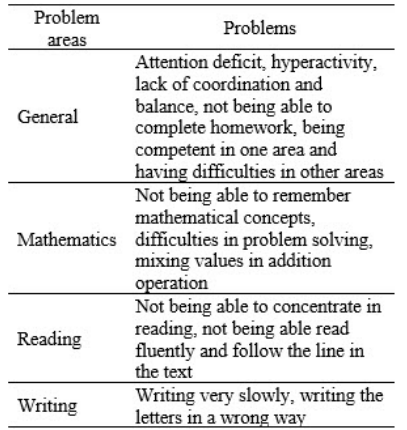
Table 1. Possible problems of chil - dren with learning difficulties, Selcuk